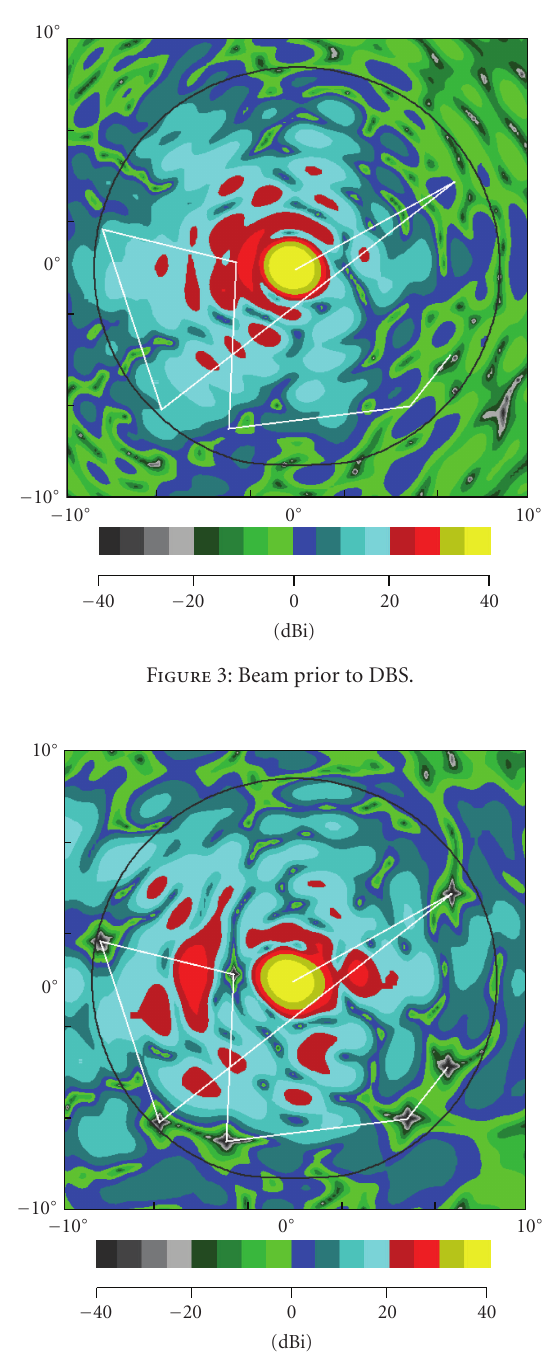
Figure 4: Synthesised beams with nulls, no errors.